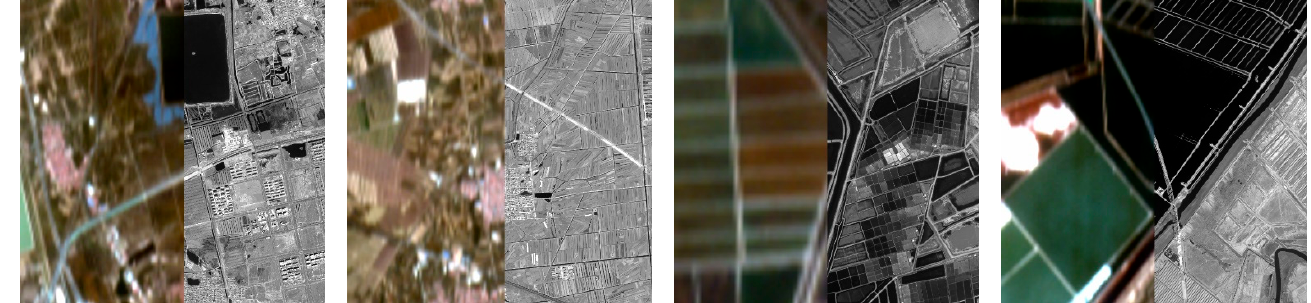
Figure A1. ZY1E hyperspectral image (spatial resolution is 30 m) and GF-7 panchromatic image (spatial resolution is 0.8 m) registered by the method in this paper, which have a resolution difference of about 37.5 times. ( a ) A hyperspectral image of ZY1E. ( b ) A panchromatic image of GF-7.